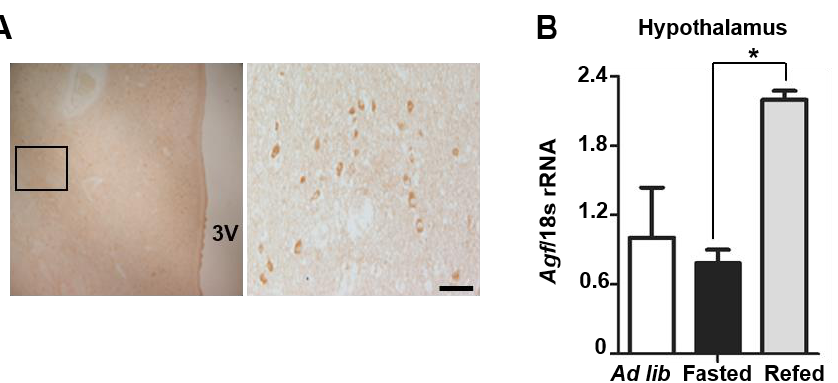
Figure 1. Angiopoietin-like growth factor (AGF) is expressed in the hypothalamus. ( A ) Immuno- histochemical detection of AGF in the human brain. The boxed area within the image indicates a magnified field. ( B ) Agf mRNA expression in the hypothalamus of ad libitum-fed , overnight fasted or refed mice, confirmed by qPCR analysis ( n = 5/group). Data represent means ± SEM (* p < 0.05). Scale bars: 50 μm.